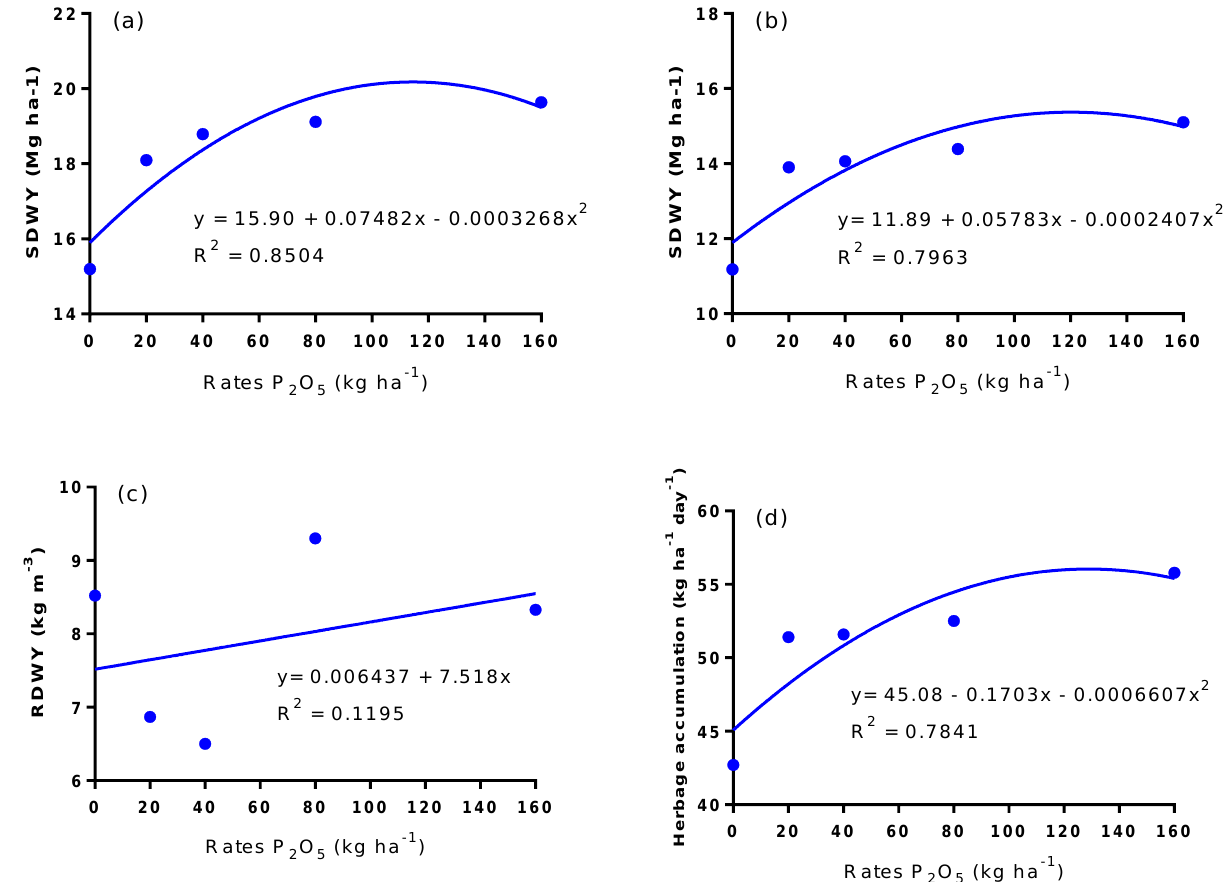
Figure 5. Regression equation means of accumulated SDWY ( a ), accumulated SDWY in the summer ( b ), root dry weight yield (RDWY) ( c ), and herbage accumulation ( d ) of ‘Mavuno’ grass as a function of phosphorus sources and rates, in the presence and absence of polymers in dystrophic Ultisol, Araçatuba, SP, 2022.